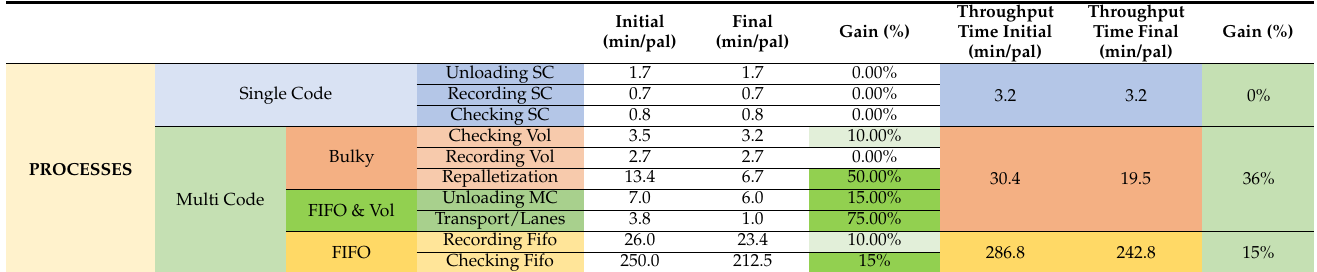
Table 10. Time reduction in each process.